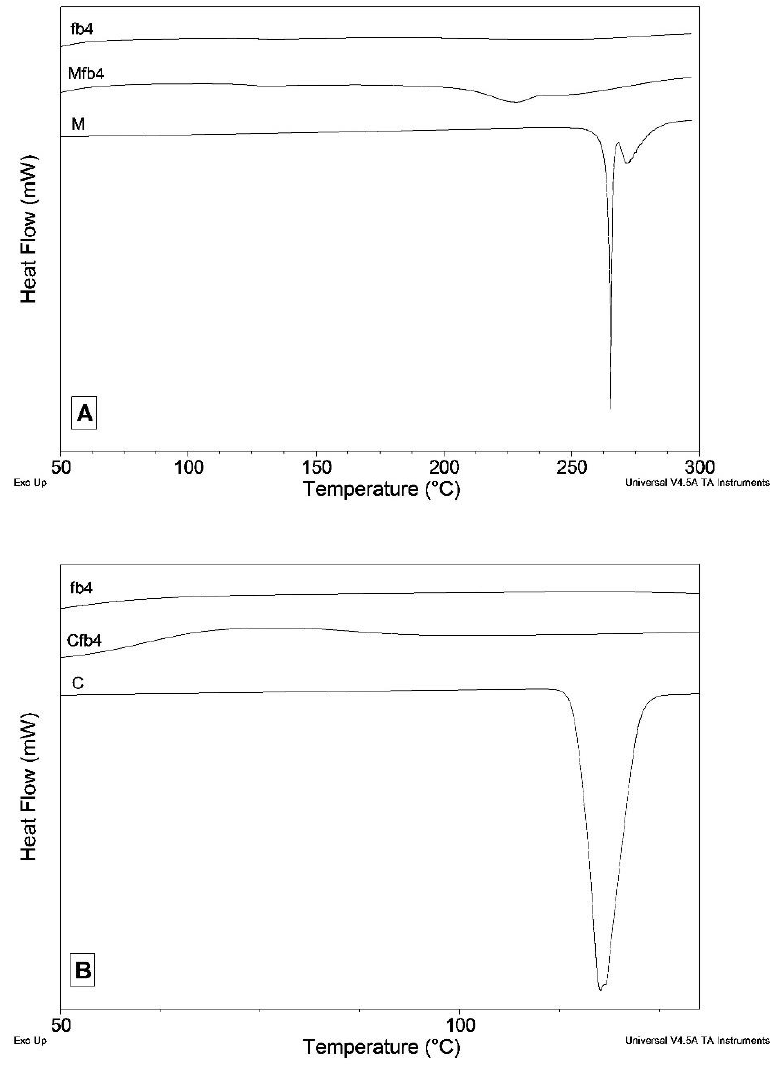
Figure 2. DSC curves of meloxicam, fb4 and Mfb4 ( A ) and carvedilol, fb4 and Cfb4 ( B ).